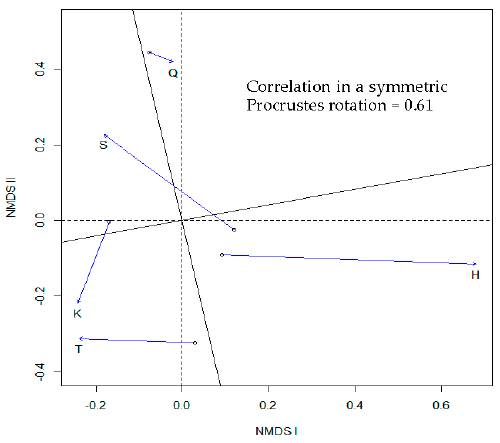
Figure 6. Procrustes plot comparing phytoplankton assemblages and DNA barcoding. Solid lines represented Procrustes residuals from both methods. Station codes represented the first letter of their names: Q: Qushou, K: Kuxin, S: Songgan, H: Heijizuo, T: Taizishang.